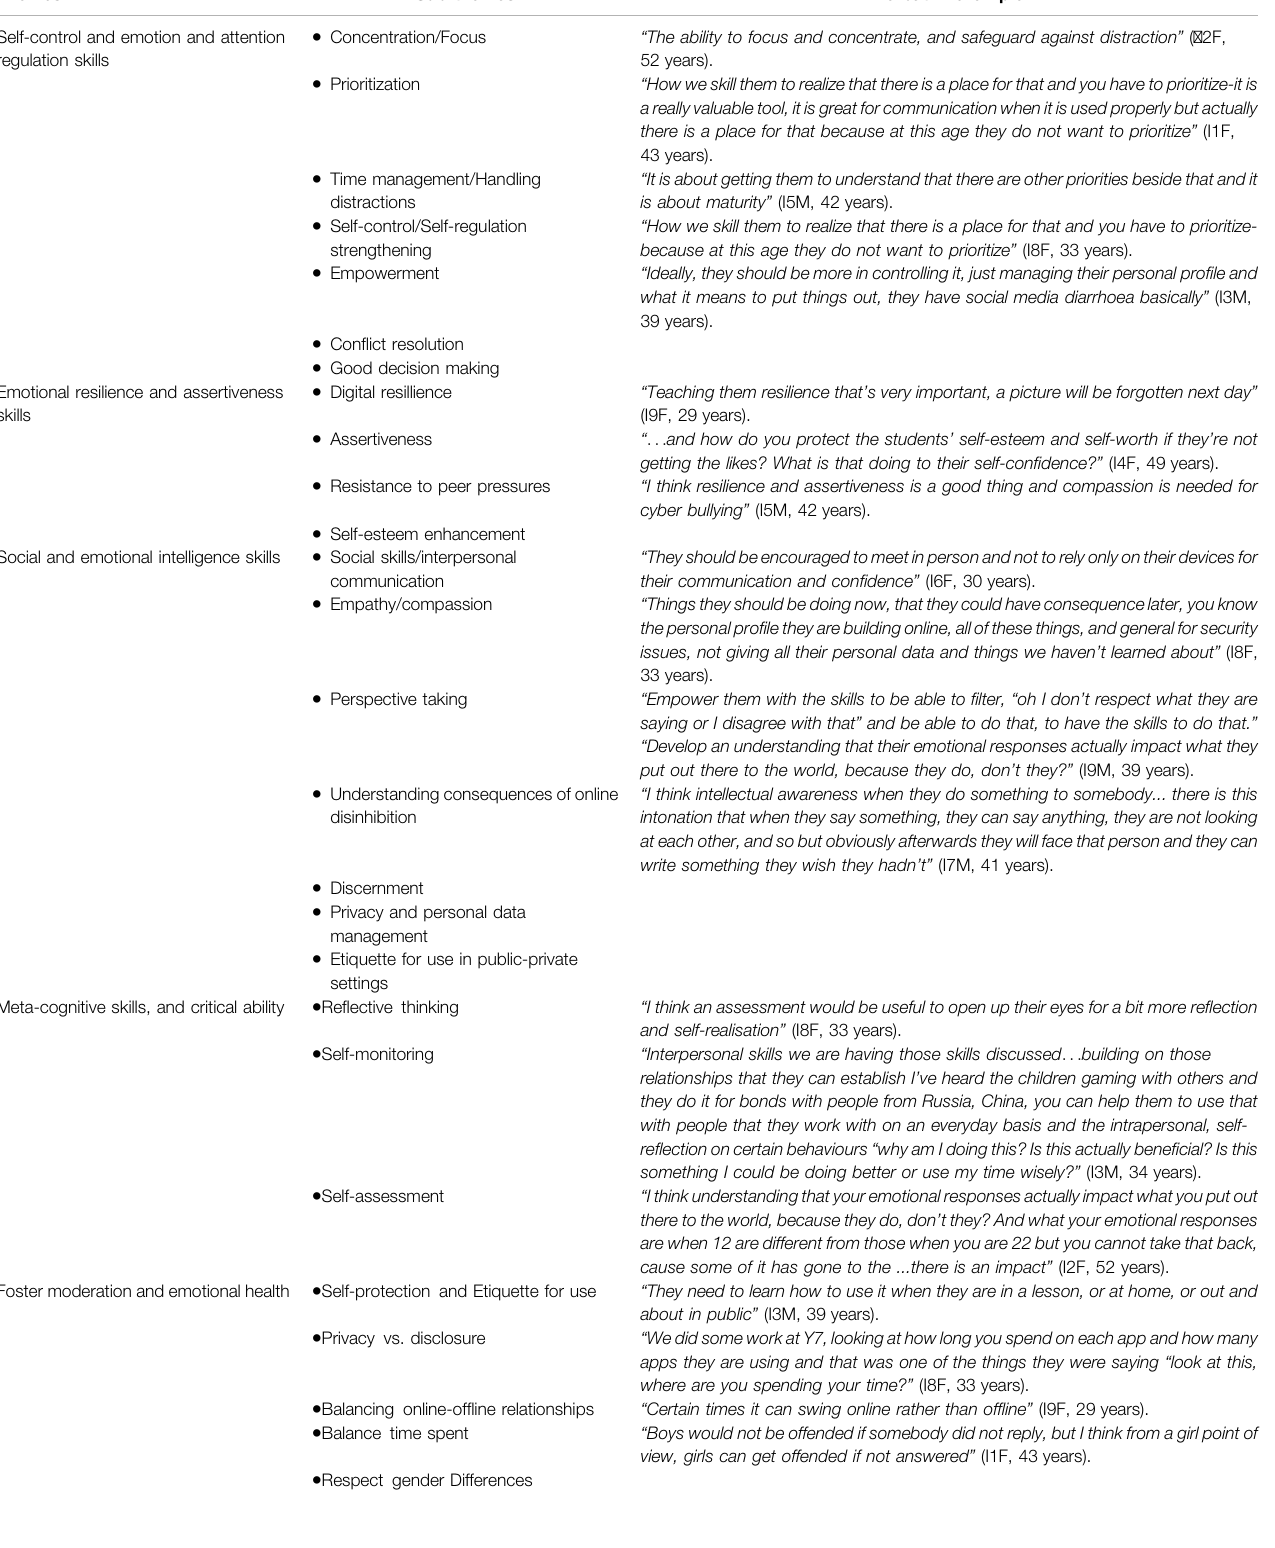
TABLE 2 | Skill development